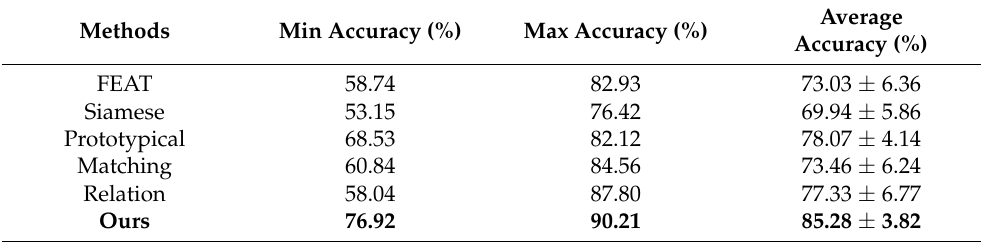
Table 7. “4-way 1-shot” recognition performance of different methods on the VA dataset.